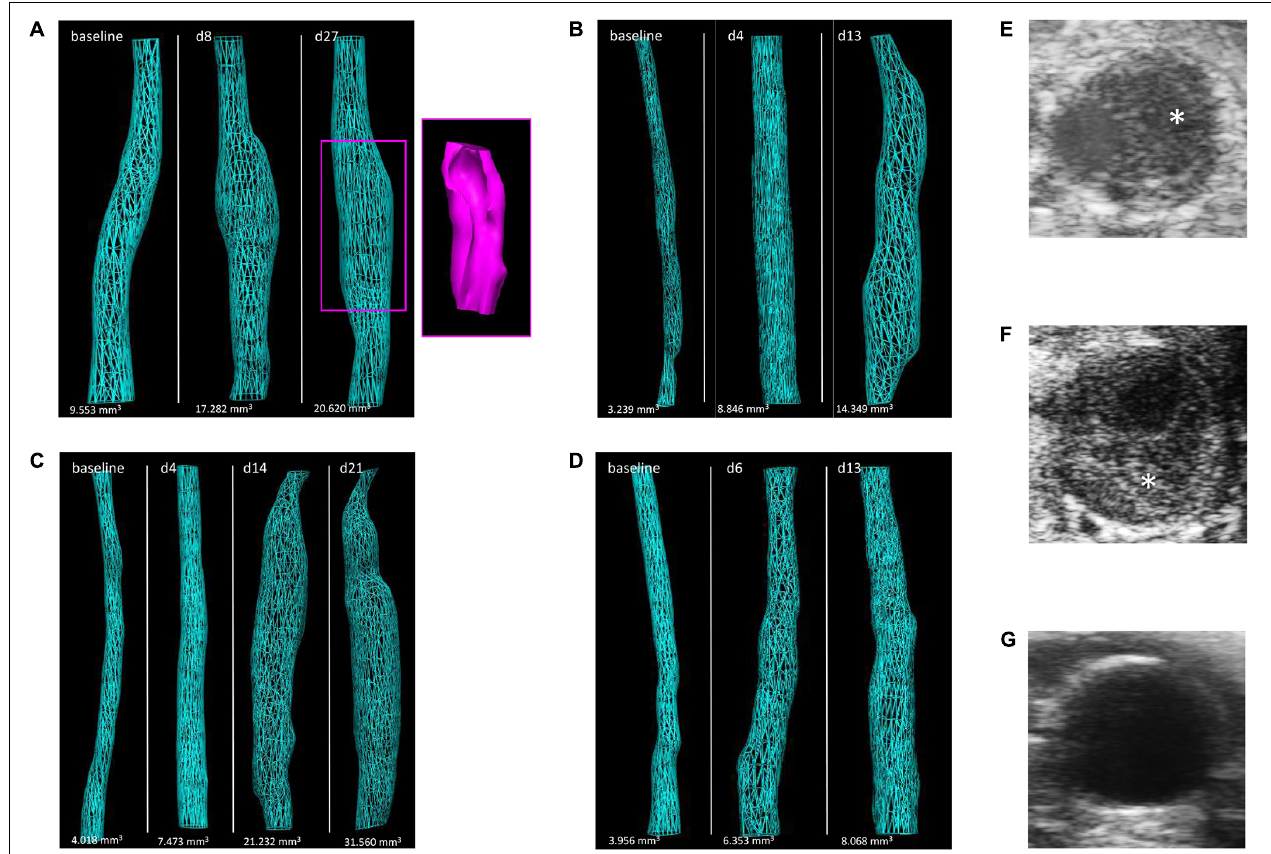
FIGURE 4 | Illustration of morphological changes by 3D US over the time course of aneurysm development in the four AAA mouse models. Images of 3D reconstructed abdominal aorta regions are shown for representative mice of the (A) AngII model (including a 3D reconstructed thrombus in pink), (B) ePPE model, (C) ePPE + BAPN model, and (D) PPE model. Examples of aorta cross-sections in the AngII model are given for (E,F) AAAs with intramural thrombus (asterisk) or (G) without